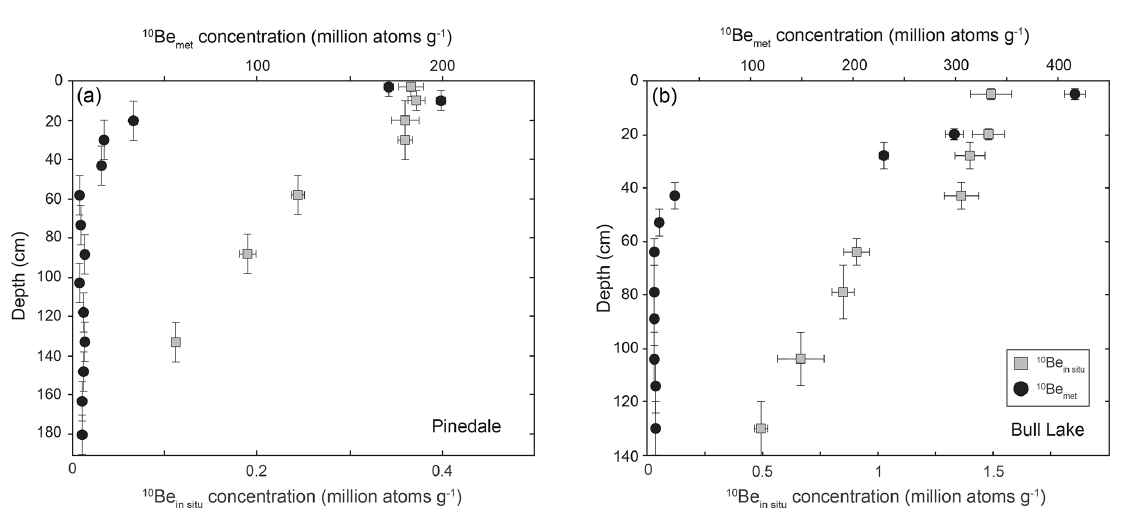
Figure 2. (a) Depth profile for the Pinedale moraine; 10 Be met concentrations were measured from the < 2mm grain size fraction of 14 samples from the same depth profile as analyzed for 10 Be in situ in Schaller et al. (2009a). (b) Depth profile for the Bull Lake moraine; 10 Be met concentrations were also measured from the < 2mm grain size fraction of 11 samples from the same depth profile as analyzed for 10 Be 10 Be met concentration at 94cm was not in situ in Schaller et al. (2009a). The